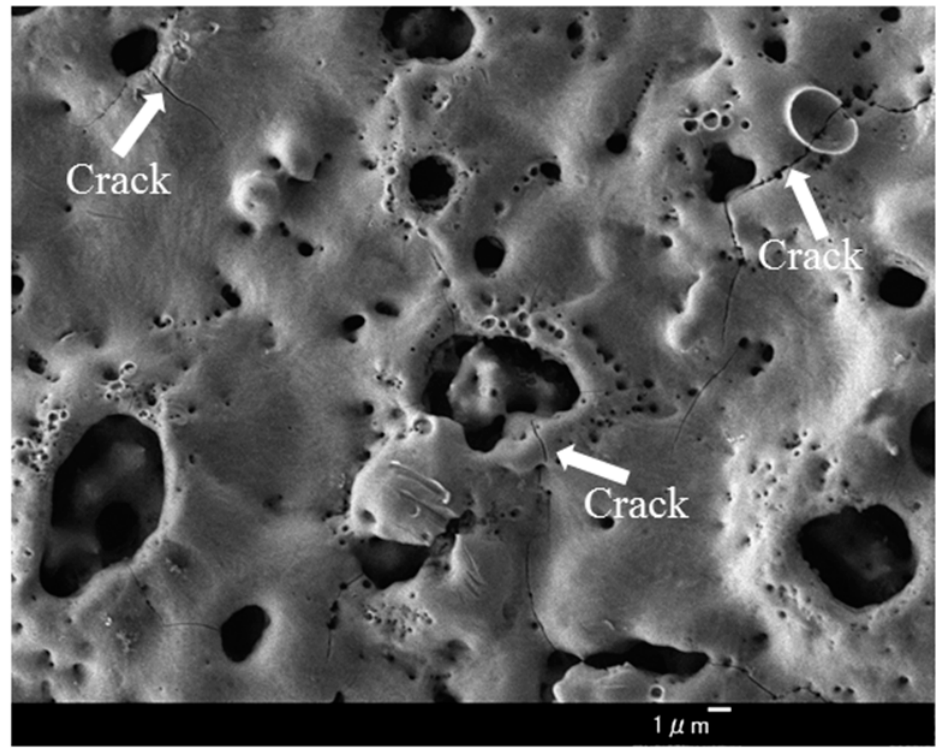
Figure 6. Crack formation around the pores on the coating surface.